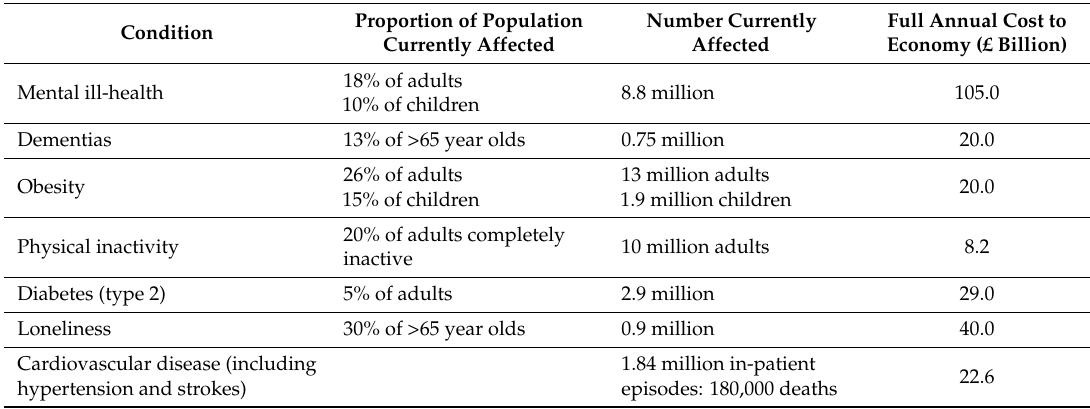
Table 1. The annual costs of the health externalities arising from modern lifestyles,